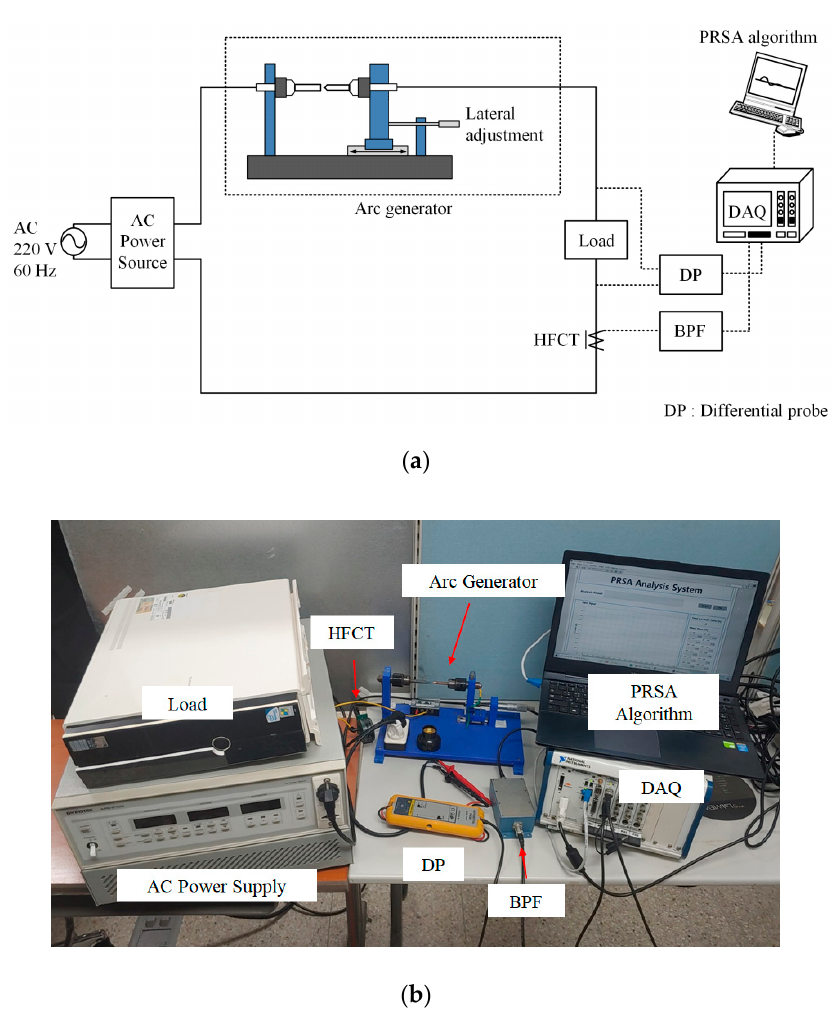
Figure 4. Experimental setup. ( a ) Circuit; ( b ) photograph.